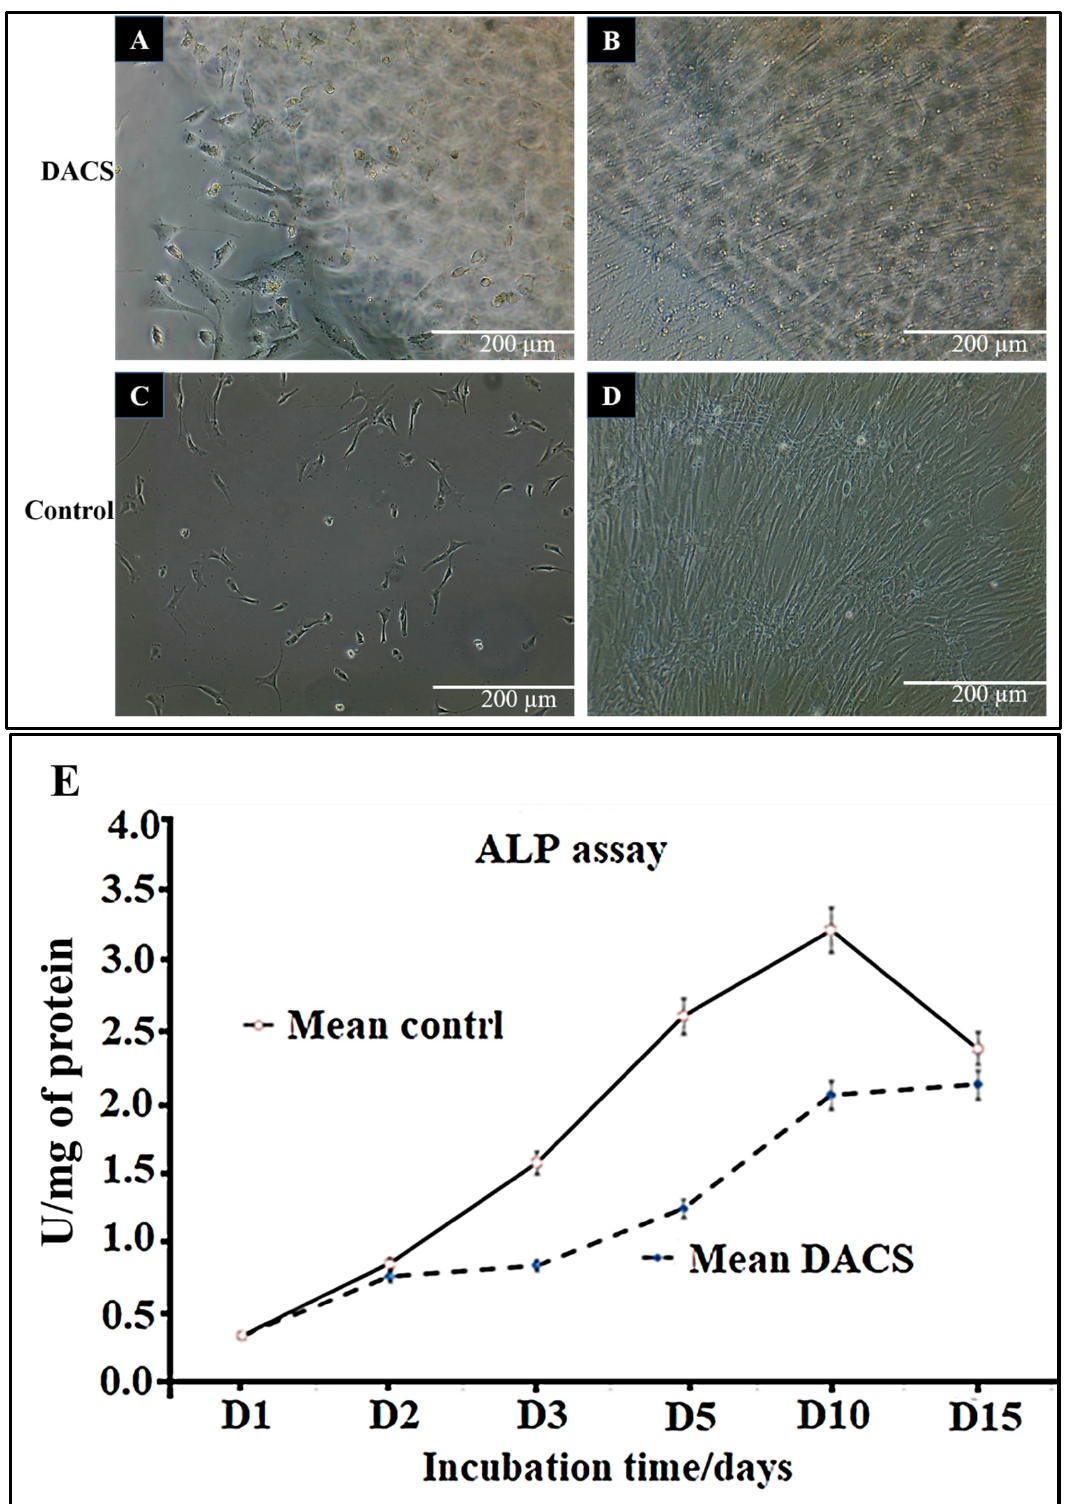
Figure 9. ( A – D ) Chondrocytes attachment and viability in scaffolds. ( A , B ) Chondrocytes on DACS at days 2 and 15 respectively. ( C , D ) Chondrocytes on monolayer plate control days 2 and 15 respec- tively. ( E ) Alkaline Phosphatase assay for chondrocytes proliferation for both control and DACS- seeded cells for varying culturing days. Data reported as mean ±Standard